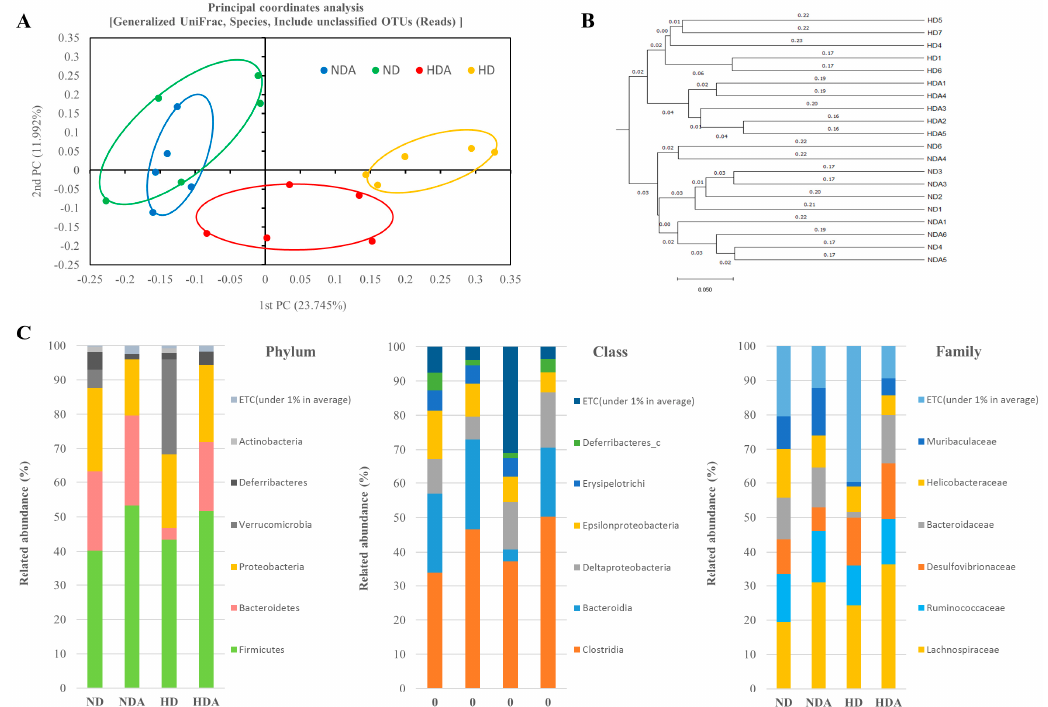
Figure 4. E ff ect of L sakei ADM14 on taxonomic composition. ( A ) Cecal microbiota composition of groups is shown by generalized UniFrac principal coordinates analysis (PCoA). ( B ) Unweighted Pair Group Method with Arithmetic Mean (UPGMA) clustering. The distance calculated by generalized UniFrac. ( C ) The relative abundance of the cecal microbiota at the phylum, class, and family levels. n = 5 per group. The nonparametric Wilcoxon signed rank test for paired data and Mann–Whitney U test for unpaired data were